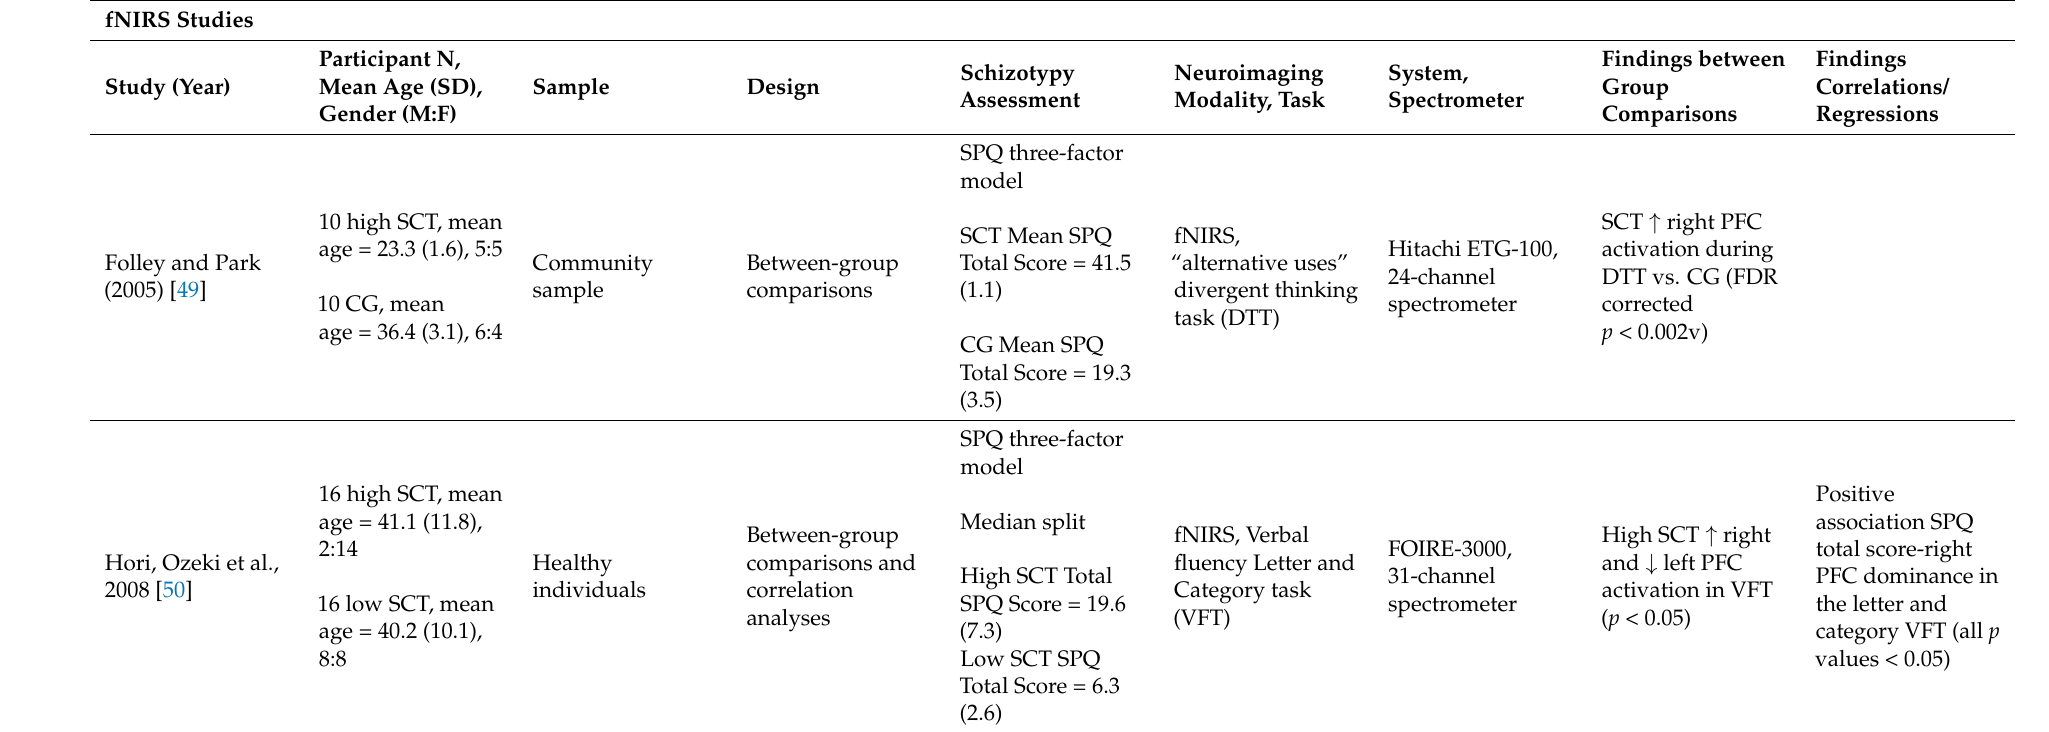
Table 1. Characteristics of the selected studies for individuals with high schizotypal